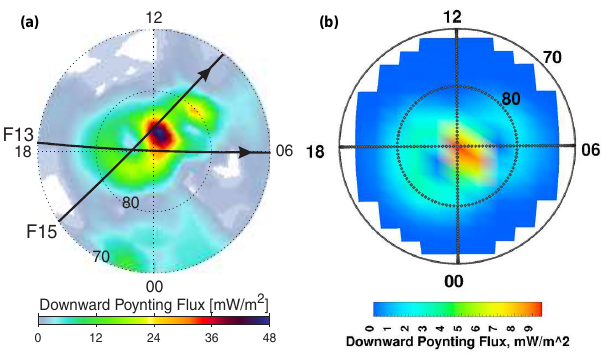
Fig. 5. Comparison of the radial Poynting flux in the Northern Hemisphere between Iridium ( a – adapted from Korth et al., 2005) and double resolution LFM (b) from 17:00 UT to 18:00